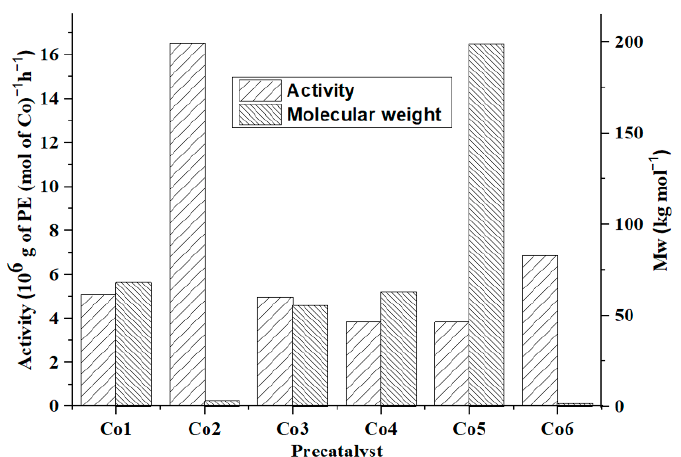
Figure 6. Catalytic activities and molecular weight of the polyethylene produced using Co1 – Co6 ; MAO as co-catalyst in each case (entries 1–6, Table